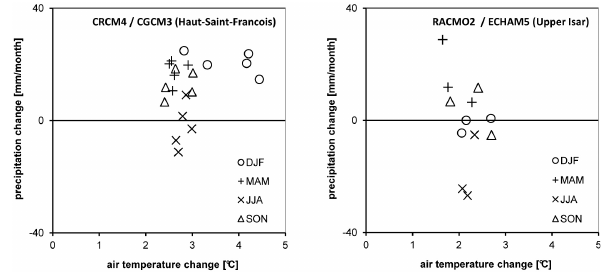
Fig. 3. Climate change signals over Haut-Saint-Franc¸ois (left) and Upper Isar (right)